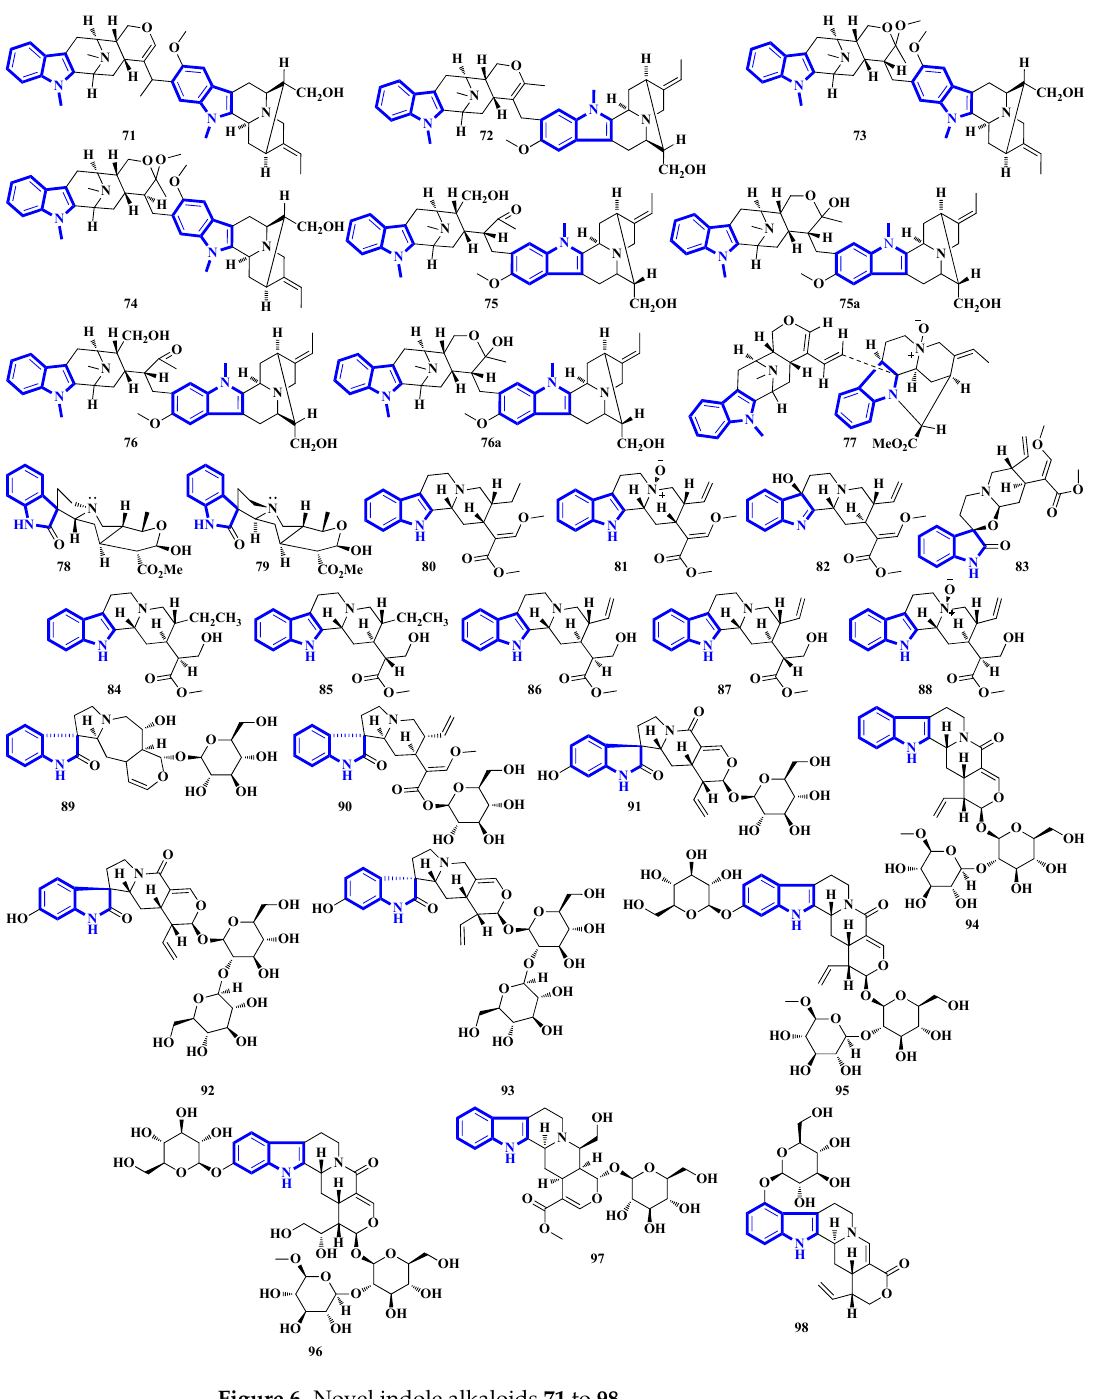
Figure 6. Novel indole alkaloids 71 to 98 . Quinazoline-containing compounds 99 to 105 were isolated from a fungus in the As- pergillus genus extracted from Sanguinolaria chinensis , a bivalve mollusk. Additionally, compounds 99 to 103 all contain a 5/5/6/5/6/6 hexacyclic ring system and 1-hydroxy-2- methyl propyl groups at C-26. Some have an acylated hydroxy, while compound 99 pos- sesses a rare amino sulfonyl group. Removing the C-14/C-15/N-16 fragment, and the two methyl groups bonded to C-15 in compounds 99 to 103 yields the structural framework for compounds 104 and 105 [39]. Compounds 106 to 108 are water-soluble glutamic acid